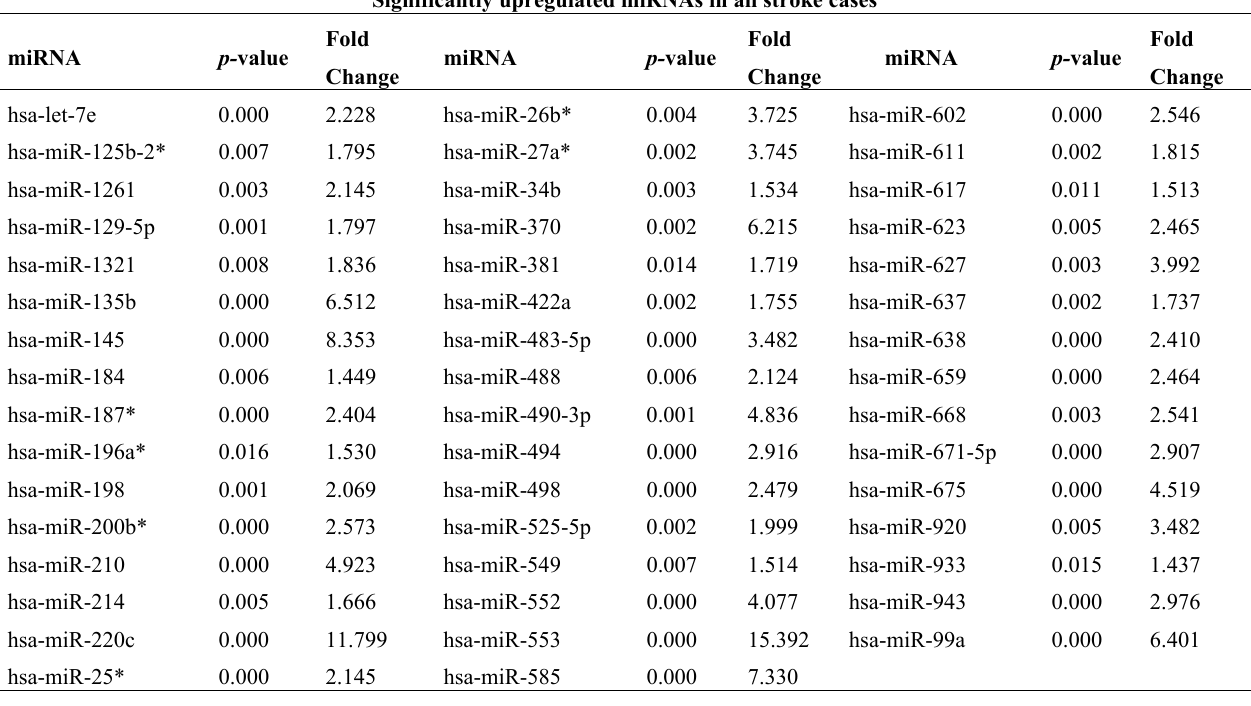
Table 1. miRNAs significantly expressed in all stroke cases. A total of 105 miRNAs were identified to be significantly (FDR p < 0.05) expressed in all stroke patients. Of these, 47 miRNAs were upregulated while 58 miRNAs were downregulated in all stroke